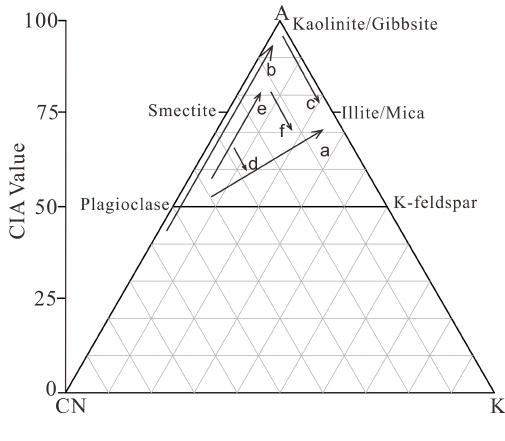
Figure 11. Theoretical weathering trend during burial diagenesis (Fedo et al., 1995): “a” is the observed weathering trend for both basaltic andesite and gabbroic diorite, “b” is the theoretical weath- ering trend for basaltic andesite, “c” is the K-metasomatism trend of the topmost basaltic andesite, “d” is the K-metasomatism trend of the lower part of basaltic andesite, “e” is the theoretical weathering trend for gabbroic diorite and “f” is the K-metasomatism trend for gabbroic